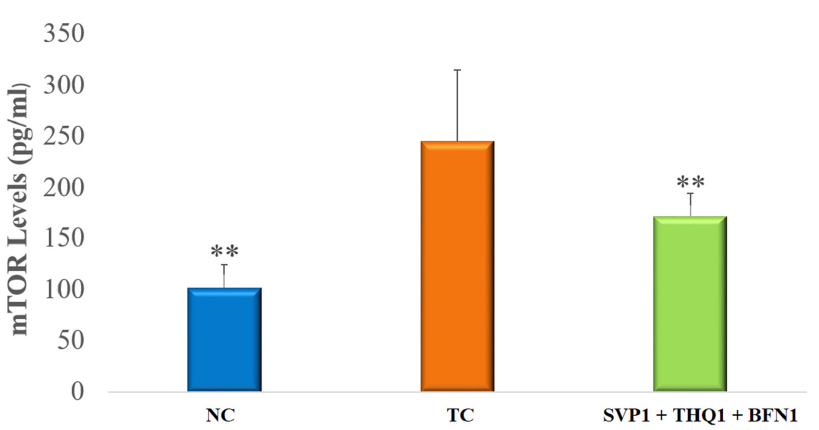
Figure 2. Effect of SVP (150 mg/kg) + BFN (5 mg/kg) + THQ (40 mg/kg) treatment on hippocampal mTOR levels. The values are expressed as mean ± SEM. ** p < 0.01 versus TC. NC; Normal Control, TC; Toxic Control.